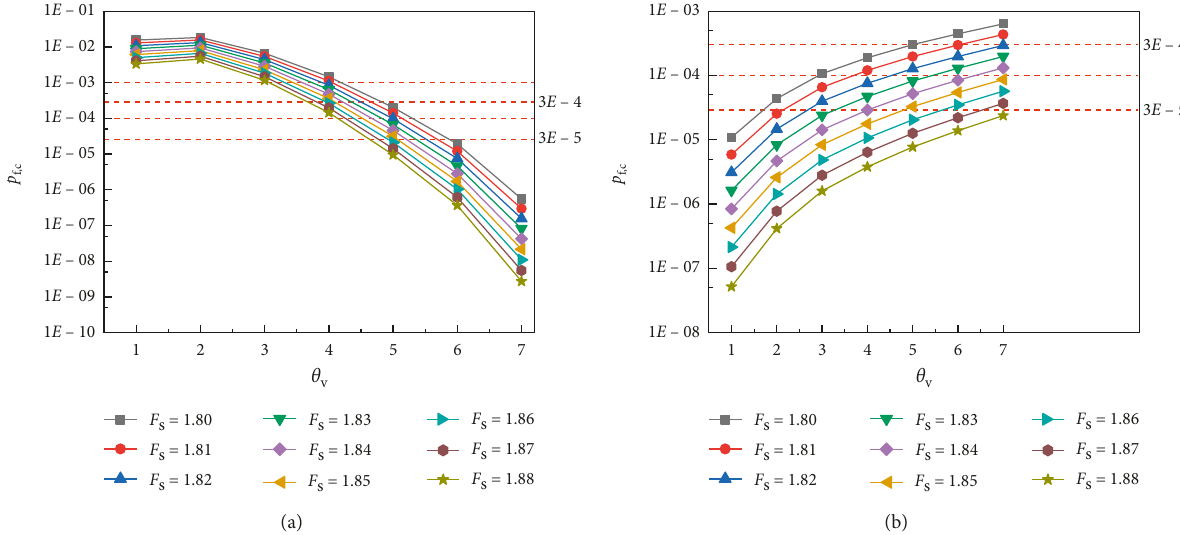
Figure 12: Probability of compression failure of tunnel liner under different random fields as a function of the vertical correlation length and factor of safety: (a) CRF and (b)